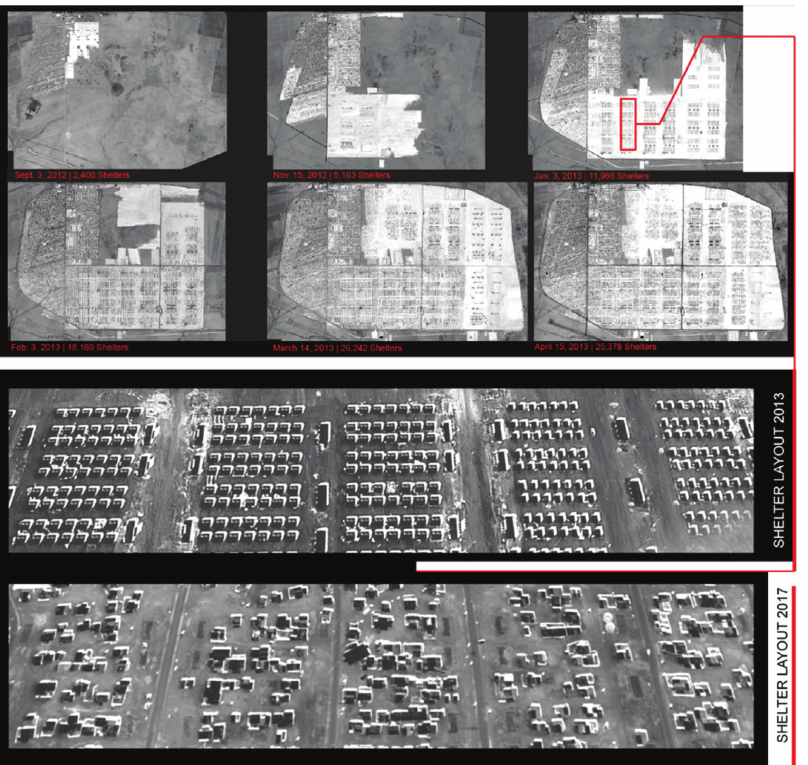
Figure 1: Top: a series of satellite images showing the rapid growth of AL-Zaatari Refugee Camp across a period of seven months. Source: www.nytimes.com/ interactive/2013/05/09/world/middleeast/zaatari.html. Bottom: Google Earth aerial images showing the transformation of Al Zaatari’s organization. The refugees reordered the shelter units, clustering them in various formations as to facilitate living near extended family in some cases, and to house businesses in